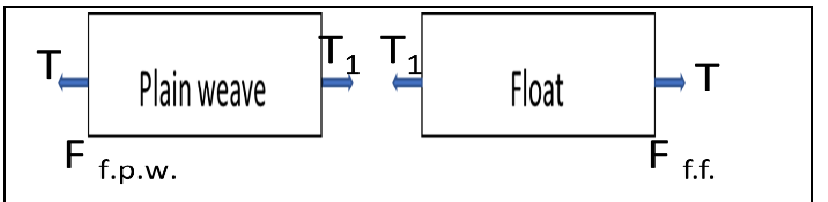
Figure 3. Free body diagram of loading. (T: Outward Tension, T 1 : Inward tension, F: Total frictional force, f.p.w: friction on plain weave, f.f: friction on float)